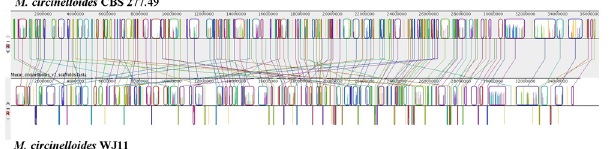
Fig 1. Alignment of the genomes from M . circinelloides WJ11 and CBS 277.49 using the MAUVE v. 2.3.1 software. Identically colored boxes, known as locally collinear blocks (LCBs), depict homologous regions in the two sequences. The vertical lines connecting the LCBs point to regions of homology between the two genomes. Numbers above the map indicate nucleotide